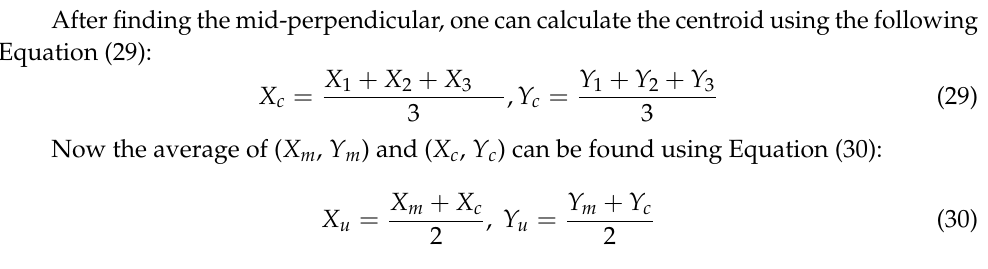
Figure 5. Mid-perpendicular using an obtuse triangle.